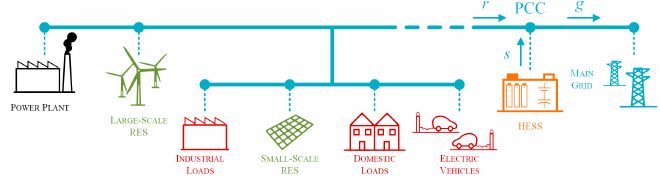
Figure 1. Schematic representation of an MG.